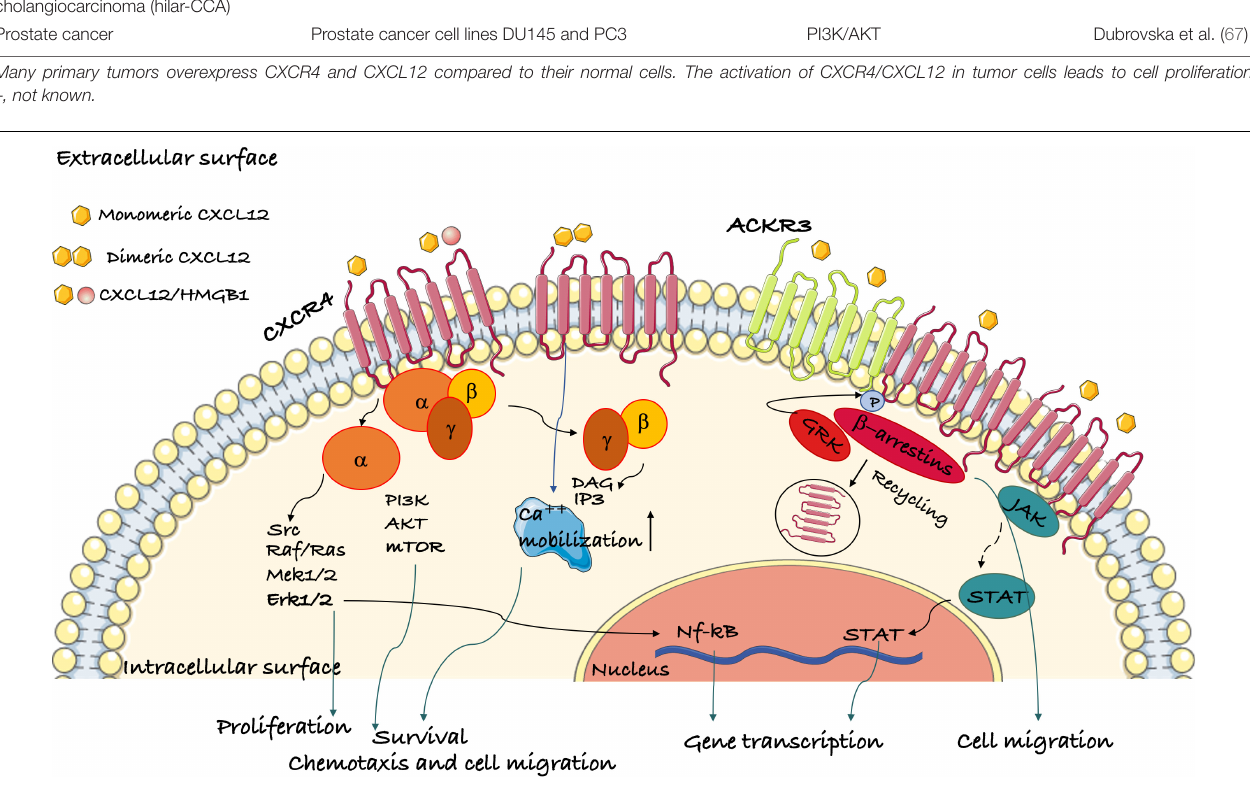
FIGURE 1 | Schematic representation of the signaling pathways activated by CXCR4. Ligand binding to CXCR4 activates G protein subunits and the downstream Ca 2 + mobilization from intracellular stores and PI3K/Akt, PLC, and ERK1/2 pathways. This results in gene transcription, cell migration, proliferation and survival. CXCR4 oligomerization can also activate the G-protein independent JAK/STAT pathway. β -arrestins are recruited following GRK phosphorylation of CXR4 and mediate its internalization. ACKR3 is another receptor for CXCL12 that can induce β -arrestin-mediated signaling both by itself or as a heterodimer with